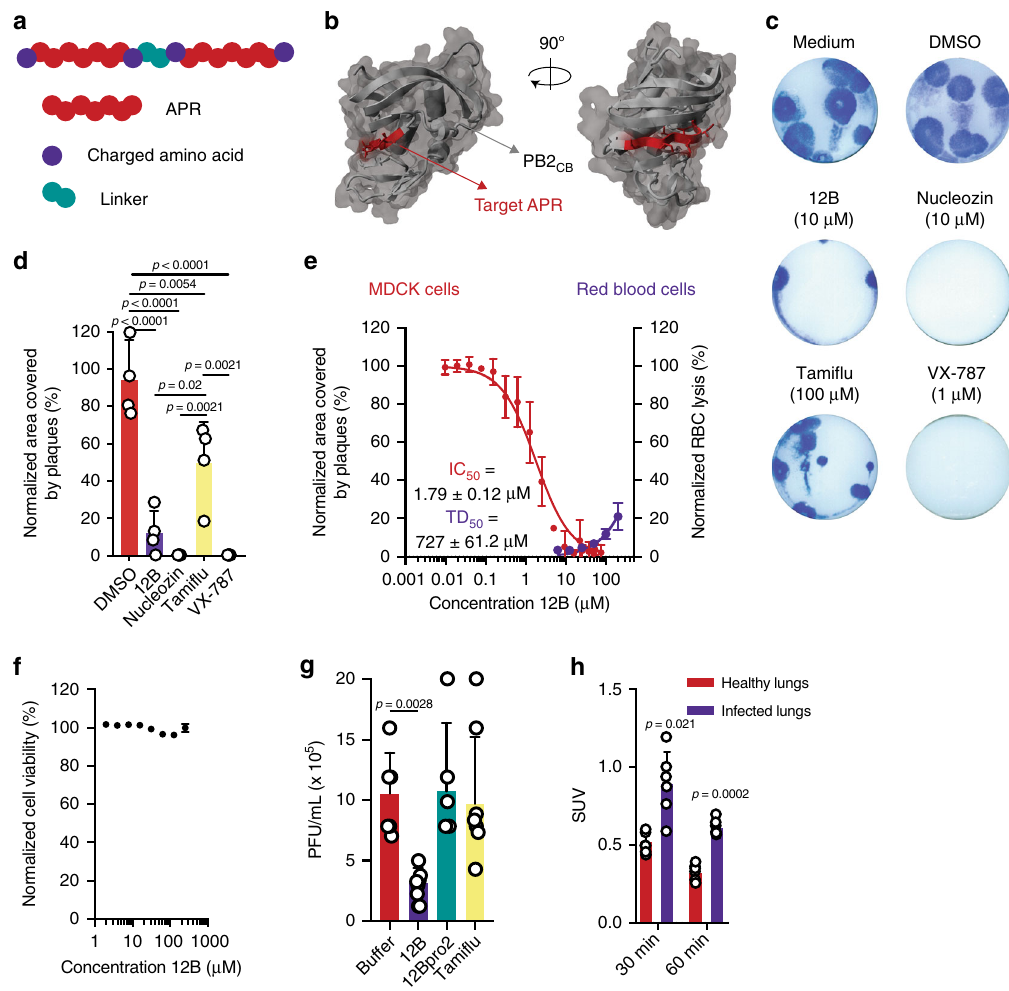
Fig. 1 APR-based design of a synthetic peptide with antiviral activity against in fl uenza A. a Graphical illustration of the peptide tandem design with the target APRs capped by charged amino acids (arginine or aspartic acid) and linked by a glycine-serine or proline-proline linker. b Cap-binding domain of the in fl uenza A/PR8 polymerase basic protein 2 (PB2 CB ) (PDB = 4ENF) 26,27 . The target APR, 381 LIQLIVS 387 , is surface exposed and highlighted in red. c Plaque-size reduction assay of MDCK cells treated with cell medium, 1% DMSO, 10 µ M peptide 12B, 10 µ M nucleozin, 100 µ M Tami fl u, or 1 µ M VX-787 2 h prior to infection with in fl uenza A/PR8. d Quanti fi cation of the area covered by plaques in c . Data are normalized to medium-treated cells and mean ± SD is shown ( n = 4 independent experiments, statistics: one-way ANOVA with multiple comparison). e Dose-dependent effect of peptide 12B on area covered by plaques (red curve, left axis) and on red blood cell (RBC) lysis (purple curve, right axis). For IC 50 : data are normalized to buffer-treated cells and the mean ± SD is shown ( n = 4 independent experiments). For toxic dose (TD 50 ): data are normalized to buffer-treated (0% lysis) and 0.1% Triton-treated cells (100% lysis) and the mean ± SD is shown ( n = 3 independent experiments). f Dose-dependent toxicity of peptide 12B, after 24-h incubation on MDCK cells. Data are normalized to buffer-treated (100% viability) and 0.1% Triton-treated cells (0% viability) and the mean ± SD is shown ( n = 3 independent experiments). g Viral load in the lungs of in fl uenza A/PR8-infected mice after daily injections of either buffer, 2.5 mg/kg peptide 12B, 2.5 mg/kg peptide 12Bpro2 (all i.v.), or 25 mg/kg Tami fl u (oral gavage) for 6 consecutive days. Data are expressed as mean ± SD ( n = 13 mice over six independent experiments, statistics: one-way ANOVA with multiple comparison). h Relative concentrations (SUV) of peptide [ 68 Ga]Ga-NODAGA-PEG 2 -12B in the lungs of A/PR8-infected versus healthy mice at different time points after peptide injection. The data are expressed as mean ± SD ( n = 12 mice over six independent experiments, statistics: two-sided unpaired Student ’ s t